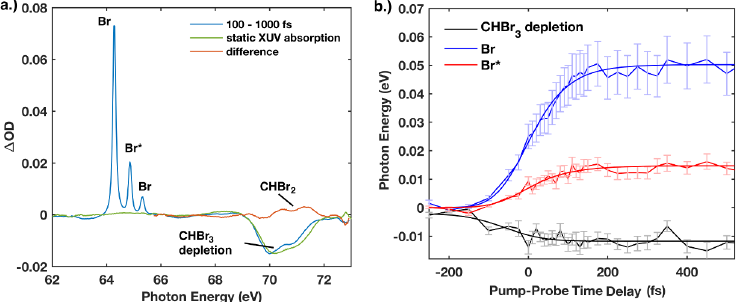
Fig. 2. UV excitation of bromoform at pump intensities of ~4x10 12 W/cm 2 : a) Long-time delay spectrum (blue, average for Δ t = 100 fs ... 1000 fs) and inverted static XUV absorption spectrum (green), scaled to match the depletion feature. The difference between the two spectra reveals the formation of a molecular fragment, which is attributed to CHBr 2 . b) Temporal evolution of the emergence of Br (blue) and Br* (red) fragments as well as the depletion of ground state bromoform molecules